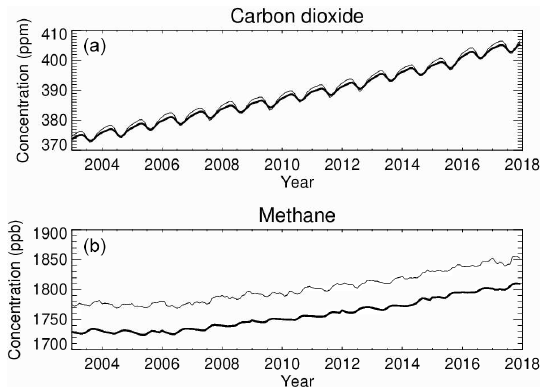
Figure 2. Time series of globally and monthly averaged concen- trations of (a) carbon dioxide (ppm) and (b) methane (ppb) over the period 2003–2017. Bold lines show mass-weighted total column averages for the CAMS Greenhouse Flux Inversion products. Thin lines show background surface measurements from NOAA’s Earth System Research Laboratory for carbon dioxide and the Advanced Global Atmospheric Gases Experiment for methane,